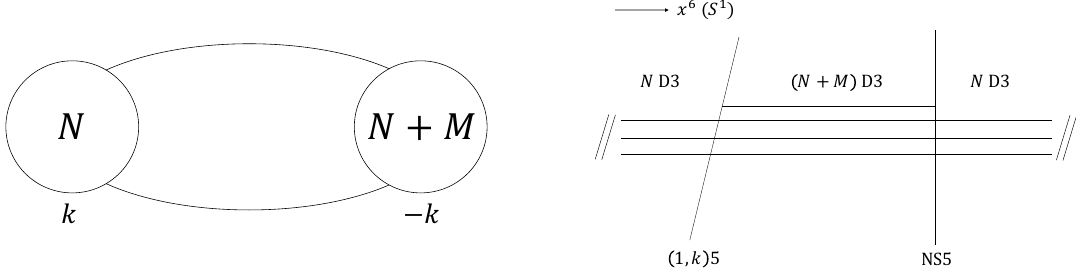
Figure 2 . [Left] The quiver diagram of the N = 3 U( N ) k × U( N + M ) − k SUSY YMCS theory coupled to two bi-fundamental hypermultiplets. This theory flows to the ABJ theory for | k | ≥ M . [Right] The corresponding type IIB brane configuration ( N = 3 and M = 1 in the figure). The horizontal direction is the S 1 and therefore identified on the both